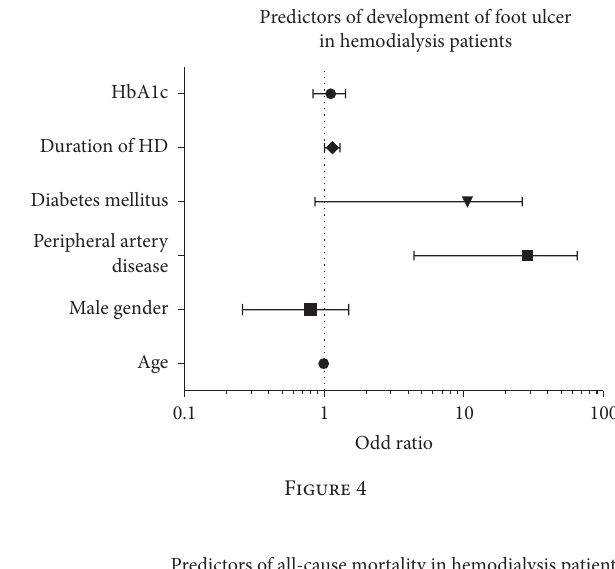
Predictors of all‐cause mortality in hemodialysis